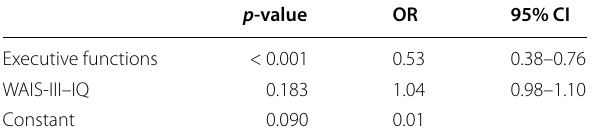
Table 4 Logistic regression predicting likelihood